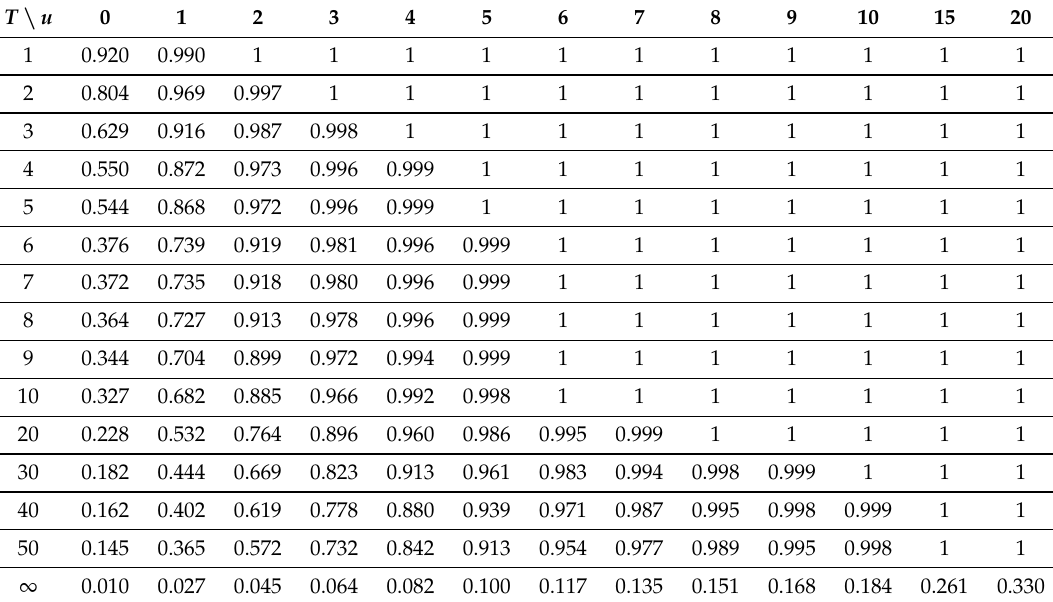
Table 6. Values of survival probabilities for the model of Example